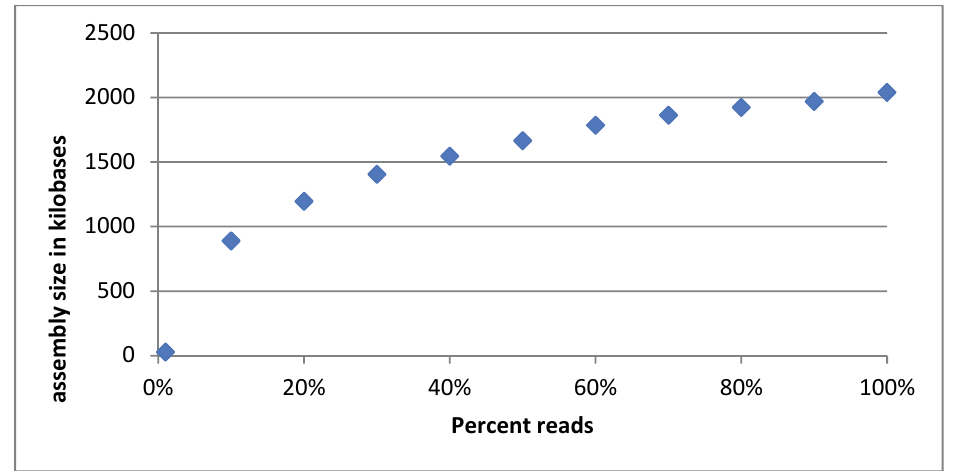
Figure 3. Rarefaction curve of the Intesti sequencing sample. The curve appears to flatten out as the percentage of reads used increases, indicating that the total assembly size is converging. This means that the most common phages are well represented in the sequencing reads. Phages that are in low abundance may not be adequately covered though.